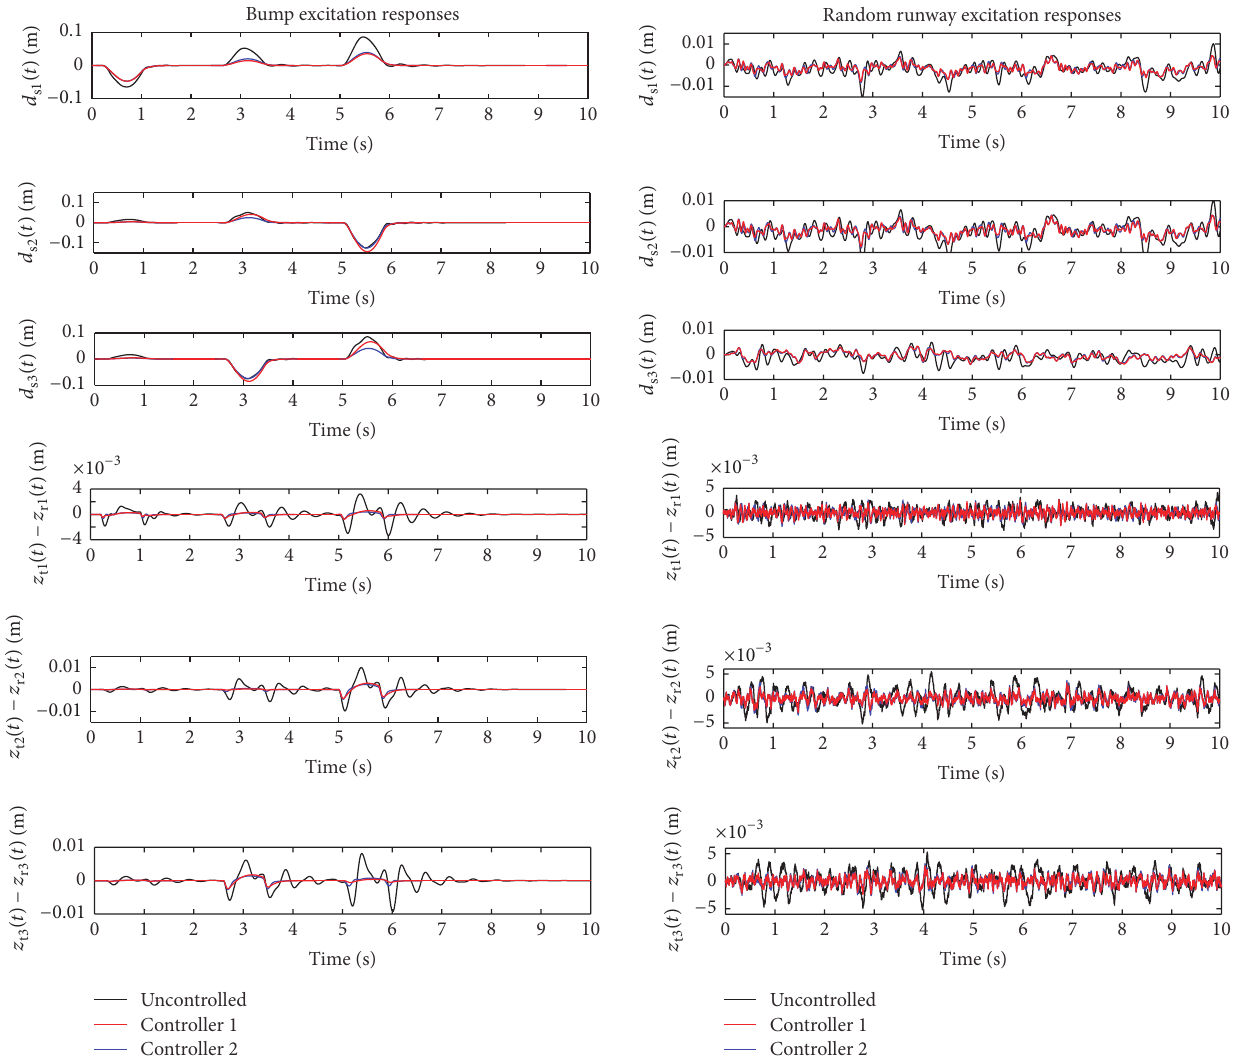
Figure 8: Controlled and uncontrolled bump and random runway responses on suspension stroke and tire deflection